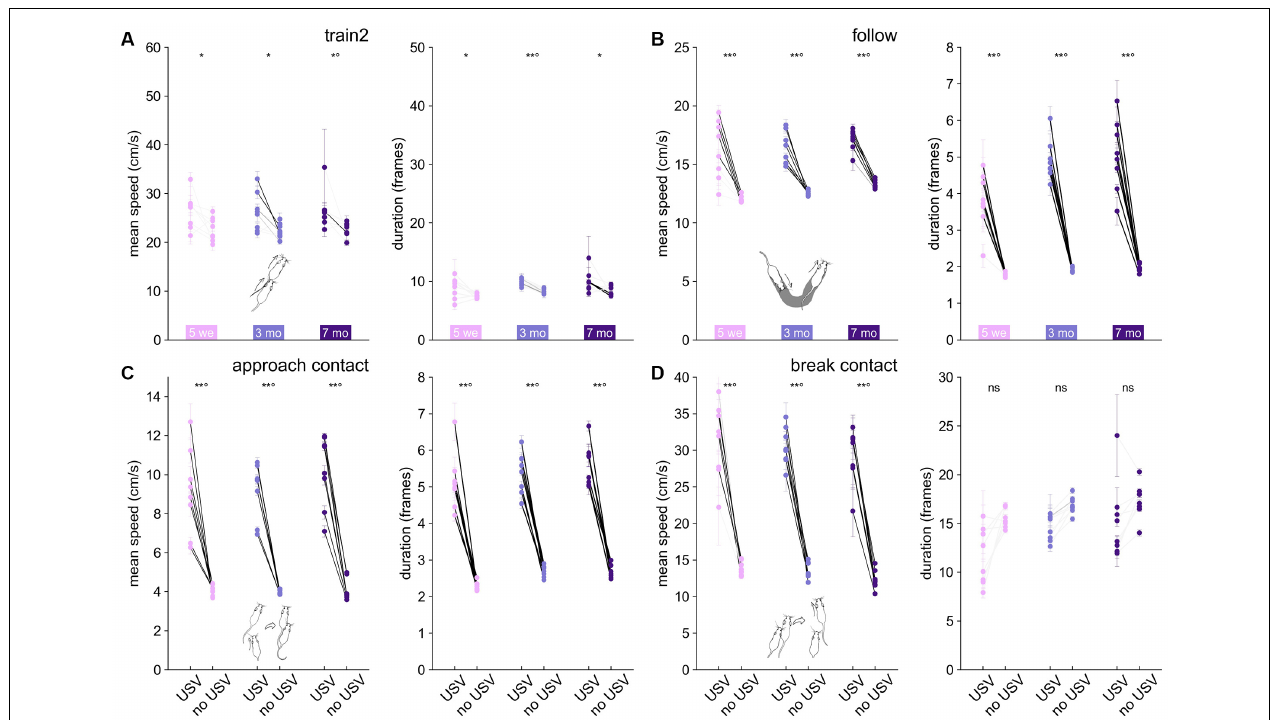
FIGURE 6 | Variations in mean speed and duration of each behavioral event according to the presence or absence of USVs in B6 females. Variations of the mean speed of the animal performing the behavior (left panel) and of the event duration (right panel) for (A) Train2, (B) follow, (C) approach contact, and (D) break contact. Paired comparisons between behaviors with and without USVs were conducted at the group level using the paired Wilcoxon test for each age class (* p < 0.05, ** p < 0.01; p -values remaining significant after correction for multiple testing over age classes were followed by ◦ ). Significant differences at the individual level using Mann–Whitney U -tests after Bonferroni correction are depicted by the color of the segments linking the mean value, with and without USVs. light gray: not significant, medium gray: p < 0.05, dark gray: p < 0.01, black: p <